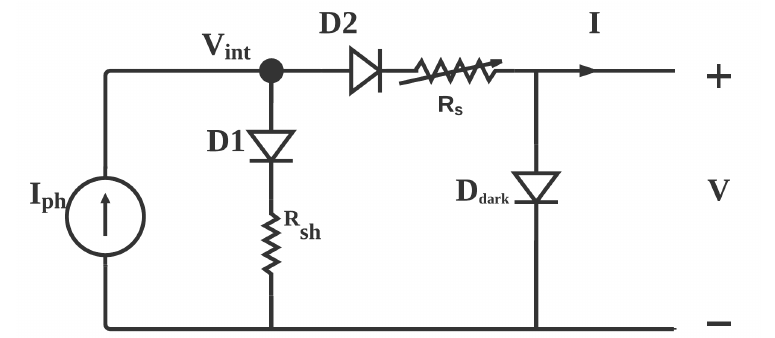
Figure 3. Proposed model for OPV by